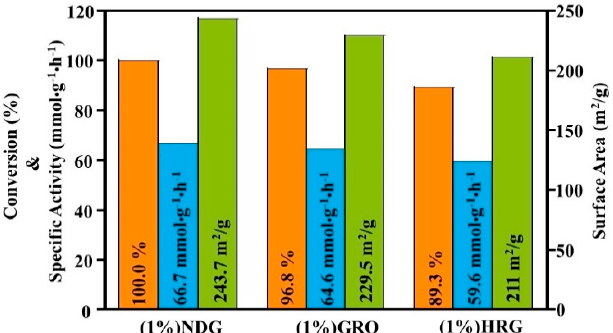
Figure 8. Graphical illustration of comparative PhCHO oxidation using (1%)HRG/MnCO 3 –(1%)ZrO 2 , (1%)GRO / MnCO 3 –(1%)ZrO 2 and (1%)NDG / MnCO 3 –(1%)ZrO 2 catalysts.